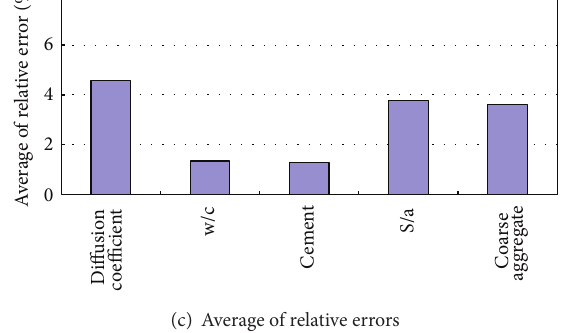
Figure 6: Comparison with results of CO 2 diffusion coefficient and relative